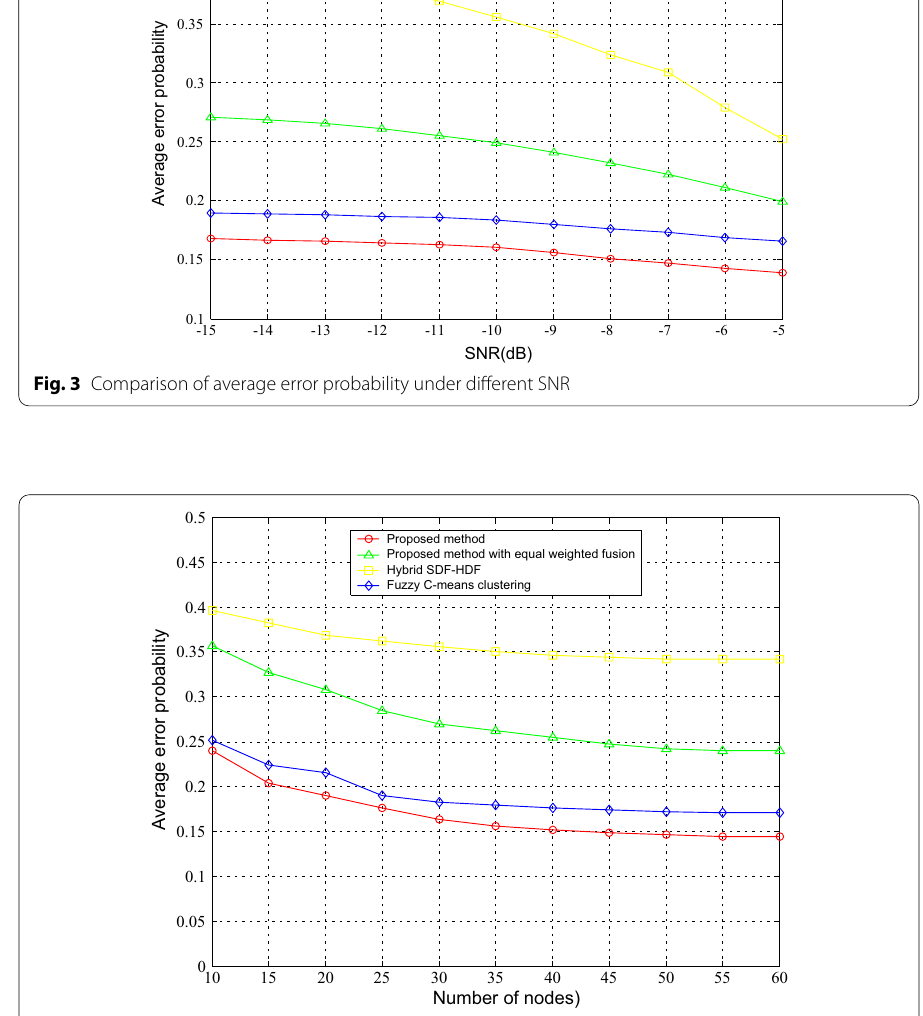
Fig. 4 Comparison of average error probability under different number of